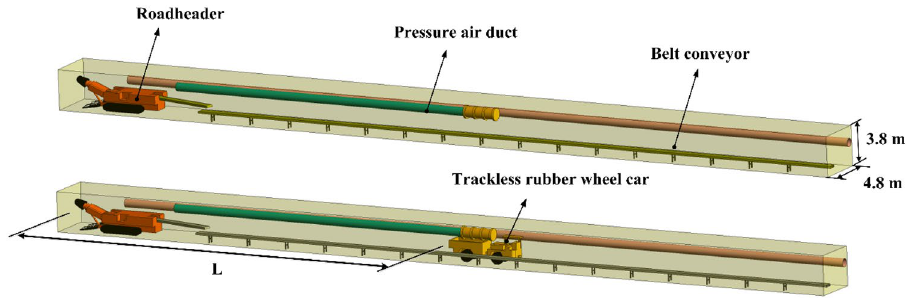
Figure 1. Geometric model of the roadway.